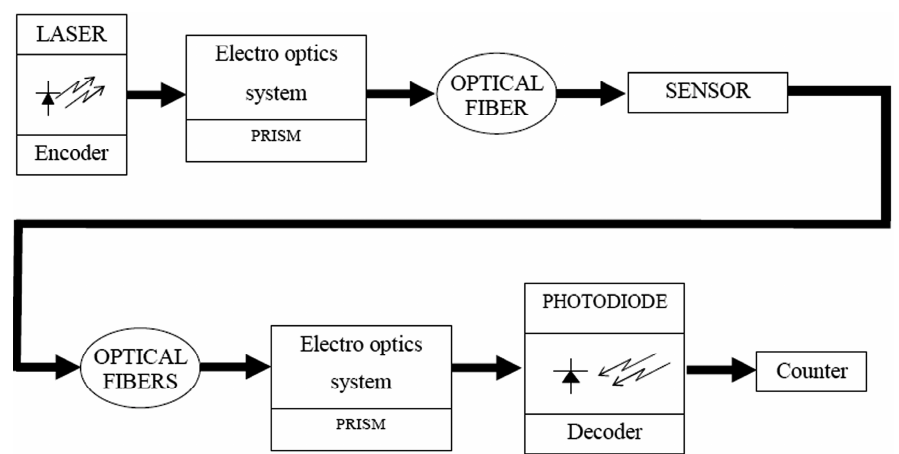
Figure 2. Diagram of the emission-detection system of the device.